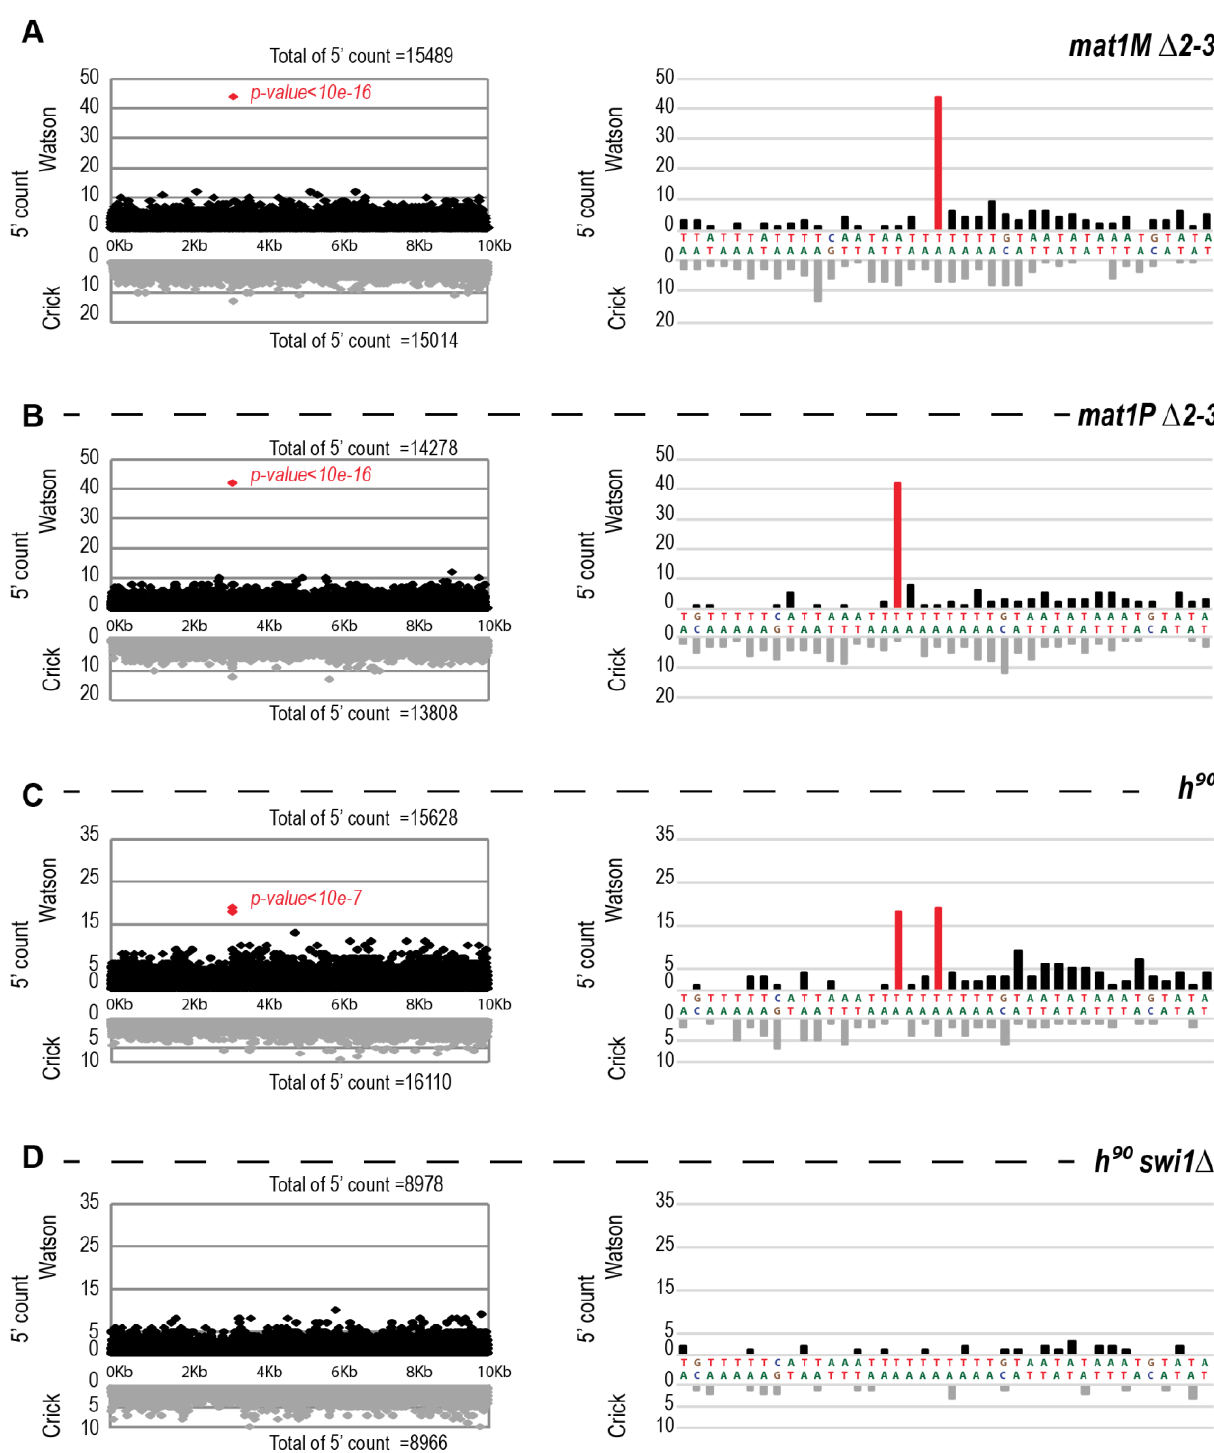
FIGURE 7: 5' count on the Watson strand is biased precisely at the site of the imprint. On the left: distribution of the 5' count of the Wat- son strand (black) and the Crick strand (gray) on the 10-kb region containing mat1 . On the right: zoom on the imprint site. Red bars repre- sent the 5' count enriched at the imprint sites. p-value is calculated using a theoretical t-student distribution that fits on the distribution of the whole-genome observed 5' count. (A) The sequencing of mat1M ∆ 2-3 strain is represented, (B) mat1P ∆ 2-3 strain, (C) h 90 strain and (D) h 90 swi1 ∆ strain. ABCD) The mat1M ∆ 2-3 , mat1P ∆ 2-3 and h 90 P genomes are used,